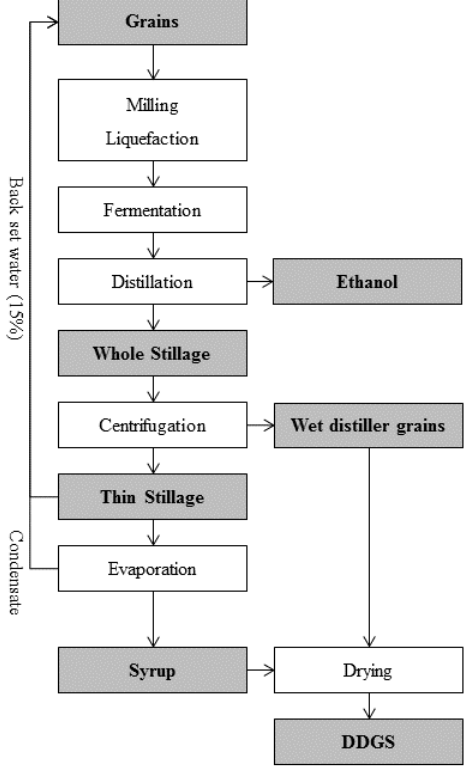
Figure 1. General overview of the main starch-based ethanol process pathways leading to the production of ethanol and dry distiller grains with solubles